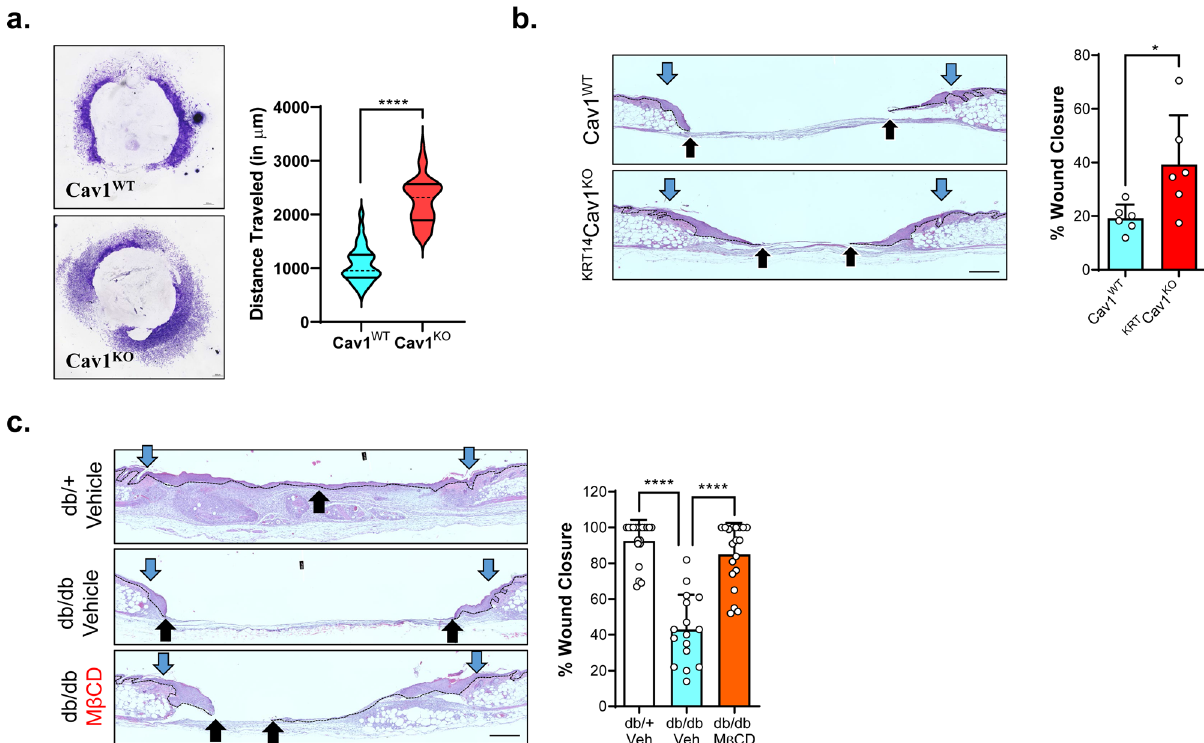
Fig. 5 Cav1 disruption accelerates wound closure in vivo. a Re-epithelialization potential of in Cav1 WT and constitutive/global Cav1 KO mice was assessed by epithelial explant outgrowths emerging from the mouse skin explants. Explant outgrowth was quanti fi ed by measuring the total distance of cells traveled measured from the concentric tissue explant to the outermost edge as well as by spectrophotometry of crystal violet solubilization of cells protruding from the explant outgrowth. n = 20 independent biological specimens, * p < 0.0001 unpaired t -test. b Rates of re-epithelialization were validated using splinted model of wound closure using mice expressing endogenous levels of Cav1 (Cav1 WT ), Cav1 global knockout mice (Cav1 KO ) and tamoxifen-inducible keratinocyte speci fi c Cav1 knockout mice ( KRT14 Cav1 KO ) with blue arrows corresponding to wound edge and black arrows corresponding to migrating epithelial tongue; scale bar = 500 µ m. n = 6, * p < 0.05, one-way ANOVA using Tukey correction for multiple comparisons. c Rates of re-epithelialization were assayed in chronic wound model using db/db mice treated with ±M β CD with blue arrows corresponding to wound edge and black arrows corresponding to migrating epithelial tongue. n = 20, *** p < 0.001, one-way ANOVA using Tukey correction for multiple